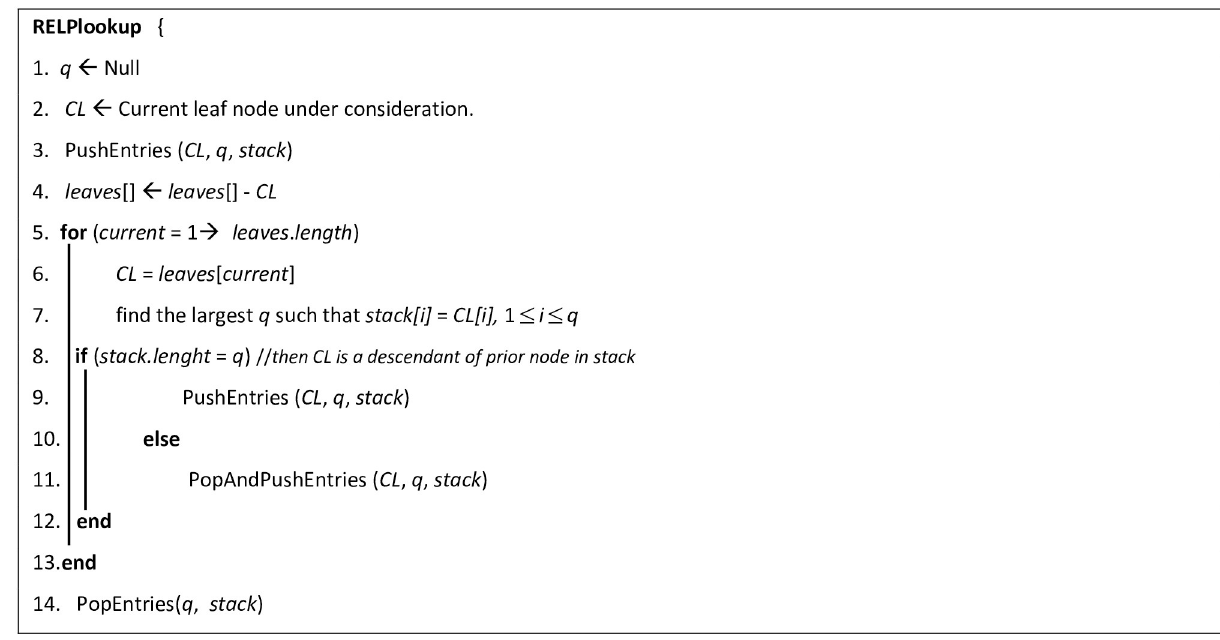
Fig 13. Algorithm